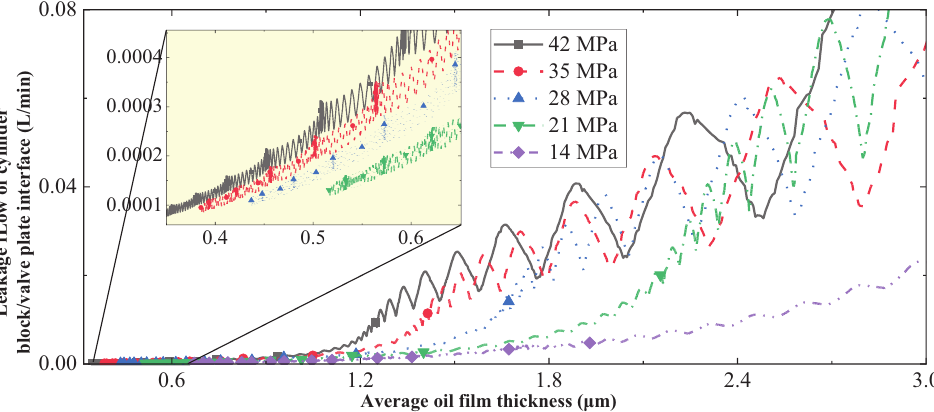
Figure 18. The relationship between oil film thickness and